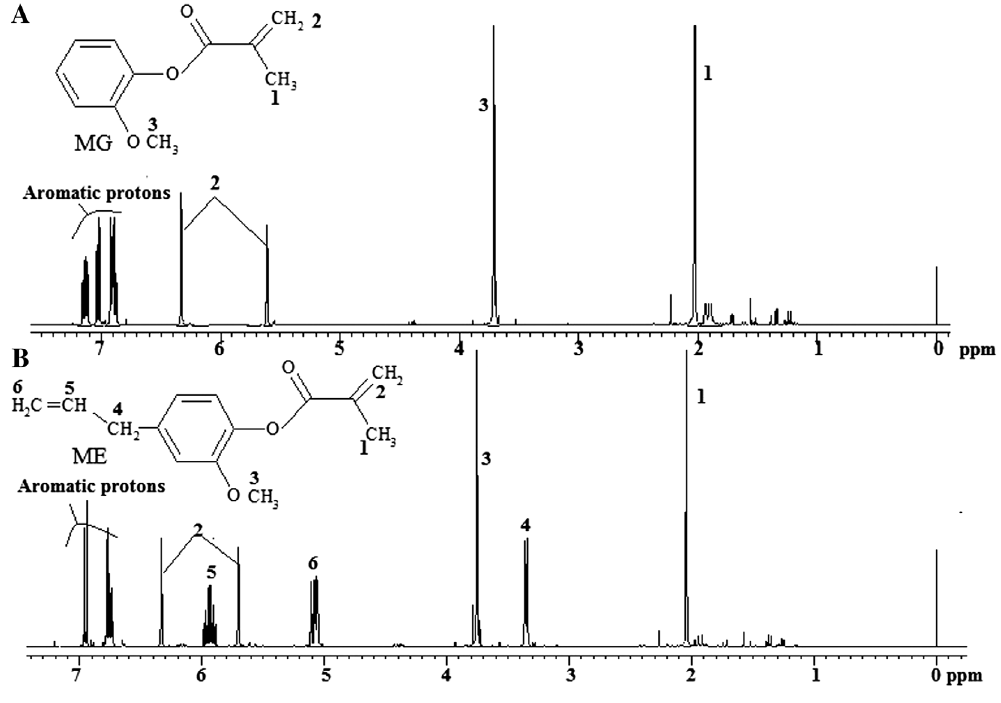
Figure 4: 1 H-NMR of (A) ME and (B)